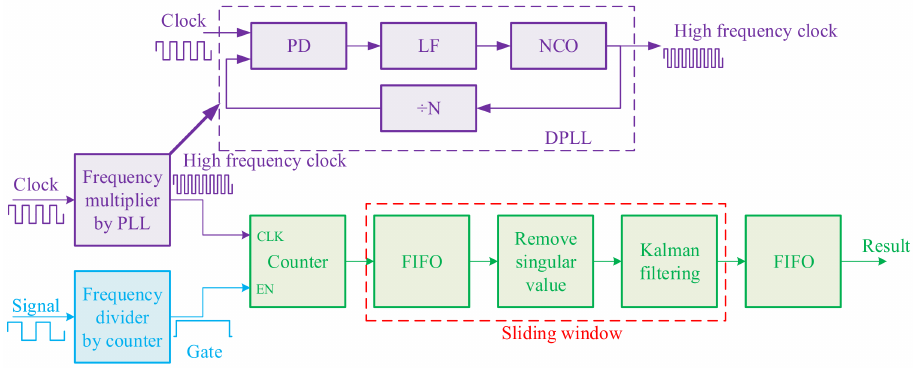
Figure 8. Process of frequency measurement.